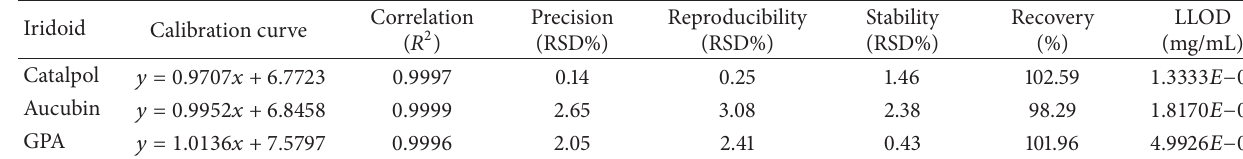
Table 3: Validation of the optimized HPLC-UV conditions for three analytes.